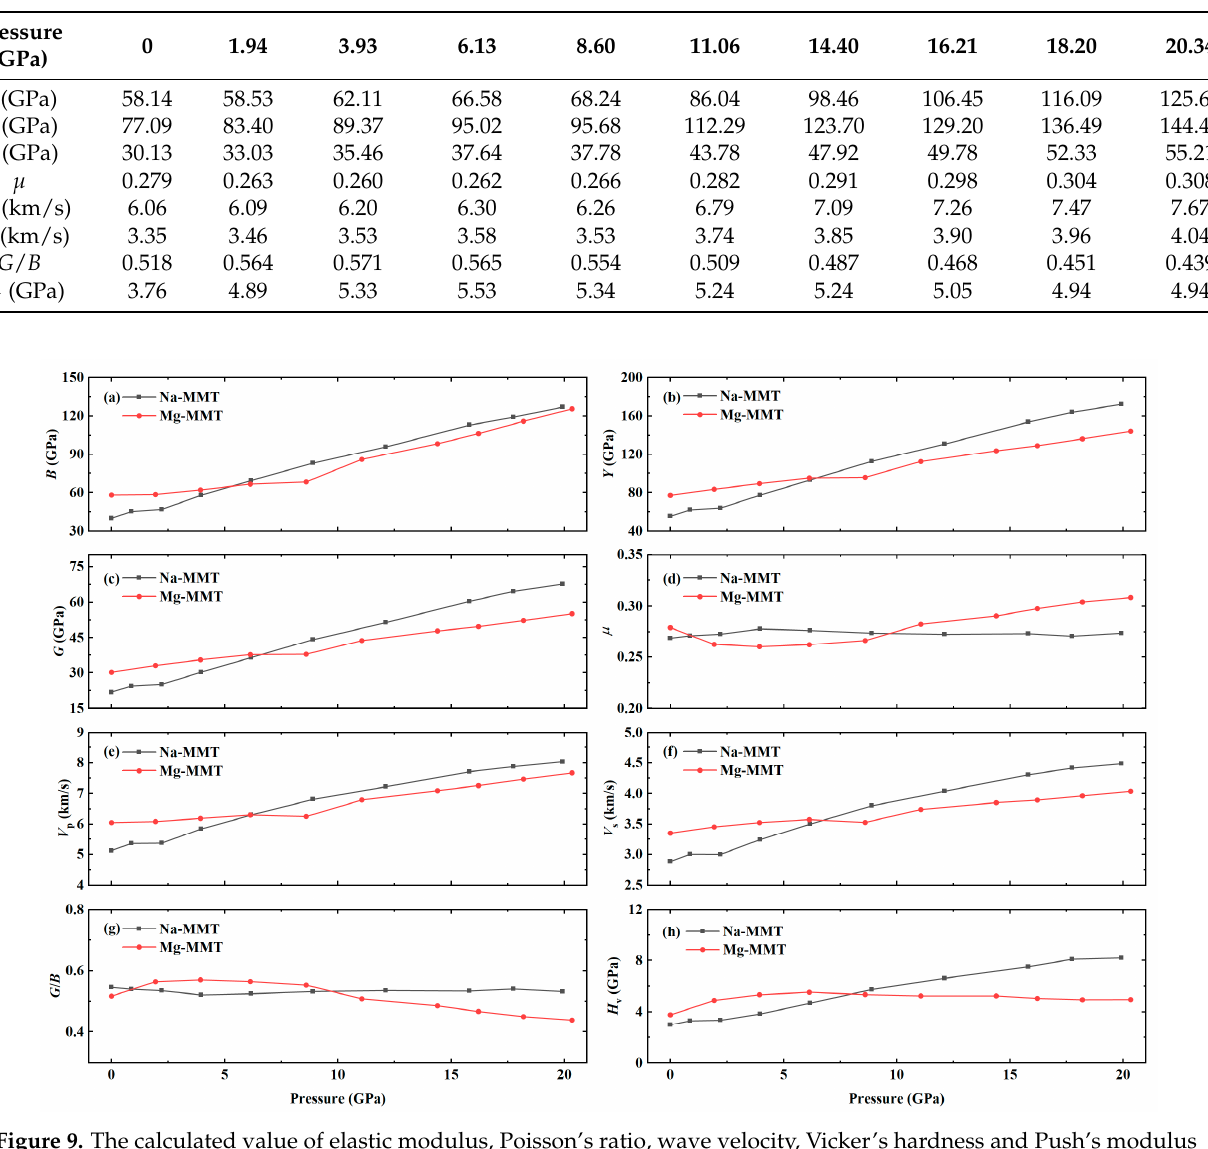
Table 14. The calculated bulk modulus ( B ), shear modulus ( G ), Young’s modulus ( Y ), Poisson’s ratio ( µ ), Pugh’s mod- ulus ( G / B ), Vicker’s hardness ( H v ), compression wave velocity ( V p ), and shear wave velocity ( V s ) of the Mg-MMT at given pressure.